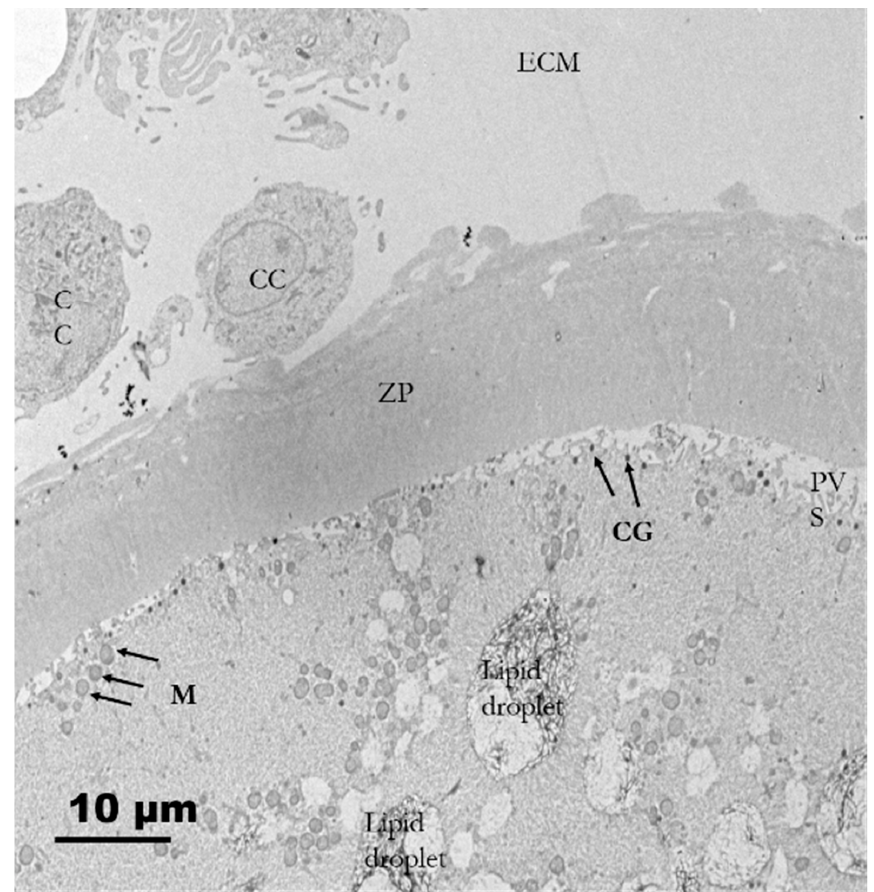
Figure 8 . Electron micrograph of matured porcine oocytes (O). Note that the increased extracellular matrix (ECM) between cumuli cells (CCs) and the retracted cytoplasmic projections from cumulus cells against the oolemma are observed. Clusters of mitochondria are distributed in the ooplasm. A single ring of cortical granules (CGs) is present beneath the plasma membrane.